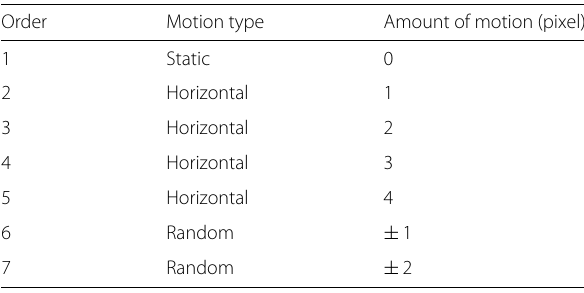
Table 1 Simple test showing how camera paths affect visual perception Order Motion